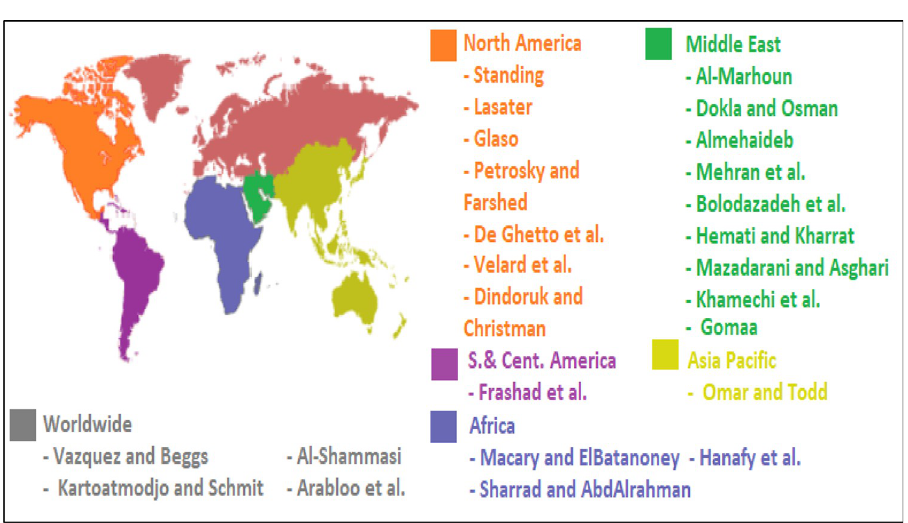
Fig 1. Previous models based on used data locations [recreated from copyright free open source